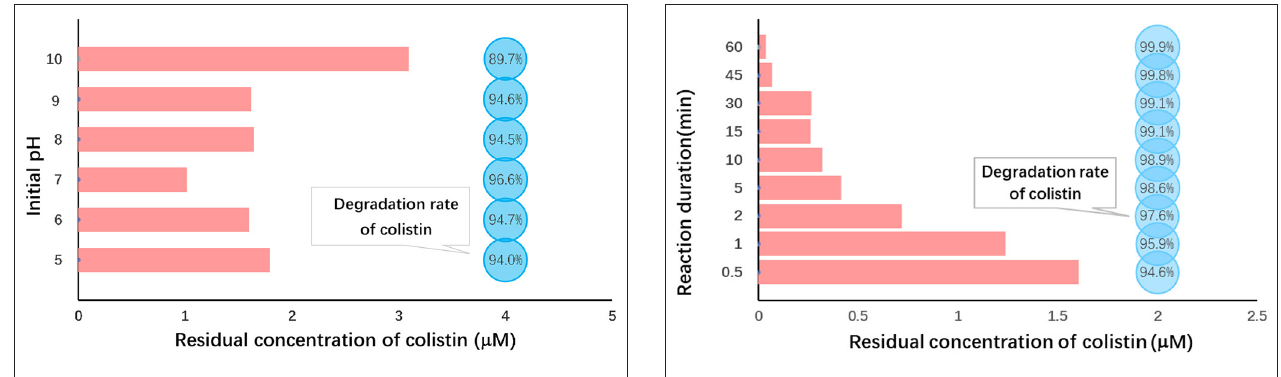
FIGURE 2 | Initial pH dependence of colistin removal. Initial colistin concentration, 30 µ M; [Fe (VI)]/(colistin) molar ration, 30; initial pH 5.0–10.0; temperature, 25 ◦ C; reaction duration, 60min.